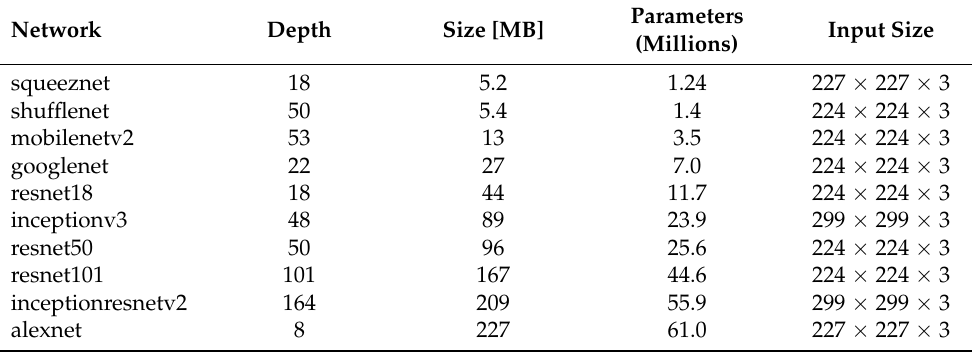
Table 2. Network information of the ten pre-trained CNN models